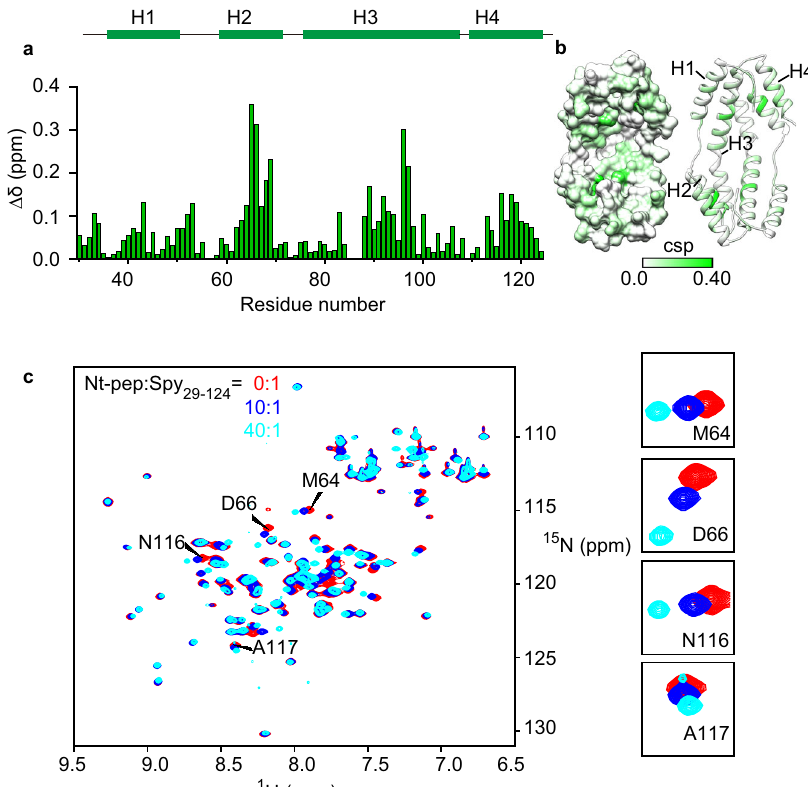
Fig. 6 Conformational constraints enable the N terminus to facilitate client release. a CSPs of amide moieties of 100 μ M [ 13 C, 15 N]-labeled Spy 29-124 upon binding with 4 mM unlabeled Nt-pep were determined and plotted against the residue number of Spy 29-124 . The secondary structure of Spy 29-124 is indicated on top. b Structural representation of Spy 29-124 (PBD: 3O39), colored according to the CSP values corresponding to a in a white-to-green scale. Color intensities correlate with CSP values, with darker colors indicating larger values. c An overlay of the 2D [ 15 N, 1 H]-HSQC spectra of 100 μ M [ 15 N]- labeled Spy 29-124 in the absence (red) and presence of Nt-pep at molar ratios (Nt-pep: Spy 29-124 ) of 10:1 (blue) and 40:1 (cyan). Representative residues with remarkable CSPs including M64, D66, N116, and A117 are labeled and their resonances are highlighted on the right. Source data are provided as a Source Data fi